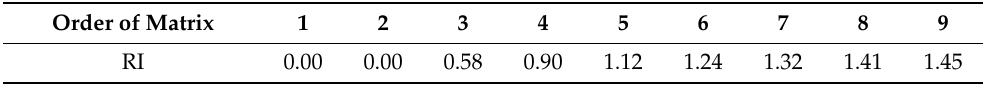
Table 1. Average random consistency